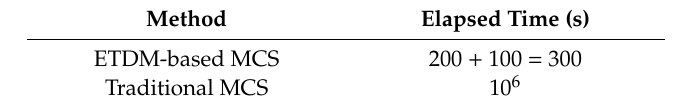
Table 1. Computation time of ETDM-based MCS and the traditional MCS with 1000 sample